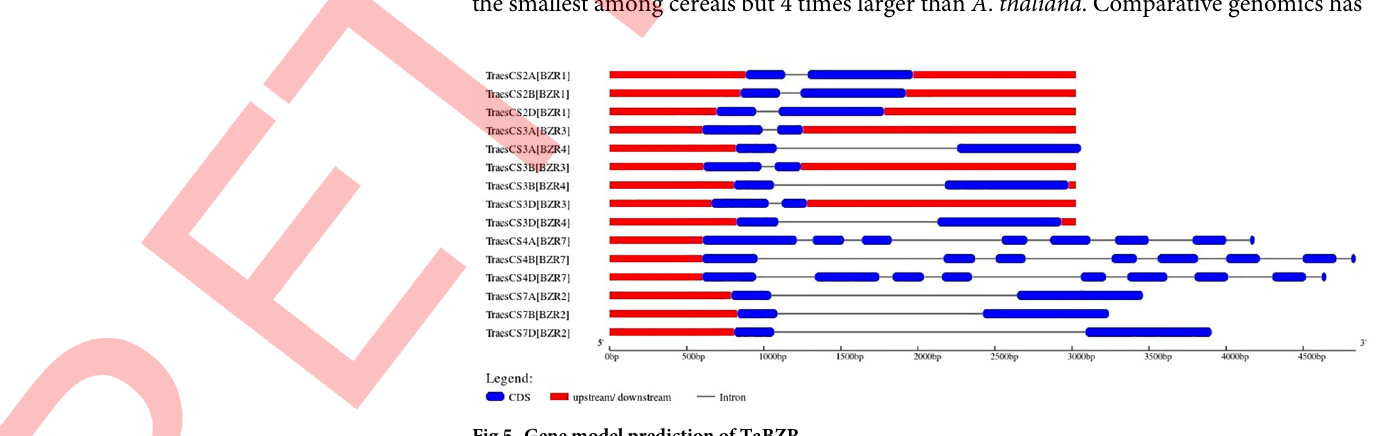
Fig 5. Gene model prediction of